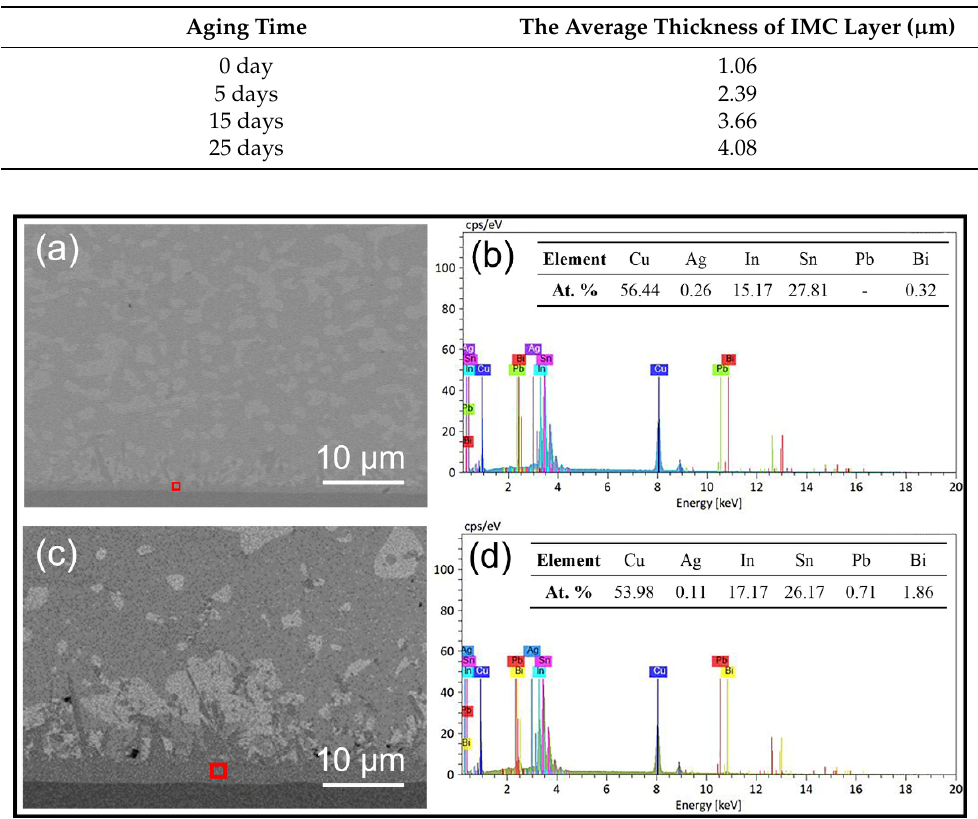
Figure 12. Composition analysis of IMC: ( a ) before aging and ( c ) after 25 days of aging: ( b ) EDS results of the region marked in ( a ); ( d ) EDS results of the region marked in ( c ).